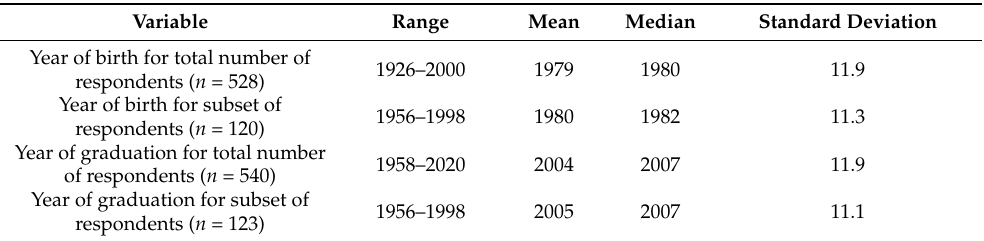
Table 2. Descriptive information for continuous exploratory variables (year of birth, year of gradua- tion) for total number of respondents ( n = 540) and a subset of respondents who made commented on low and no-contact euthanasia ( n = 123) in a mixed methods survey on ethically challenging situations encountered by veterinarians, animal health technicians and veterinary nurses globally during the early months of the COVID-19 pandemic in 2020. Variable Range Mean Median Standard Deviation Year of birth for total number of respondents ( n =